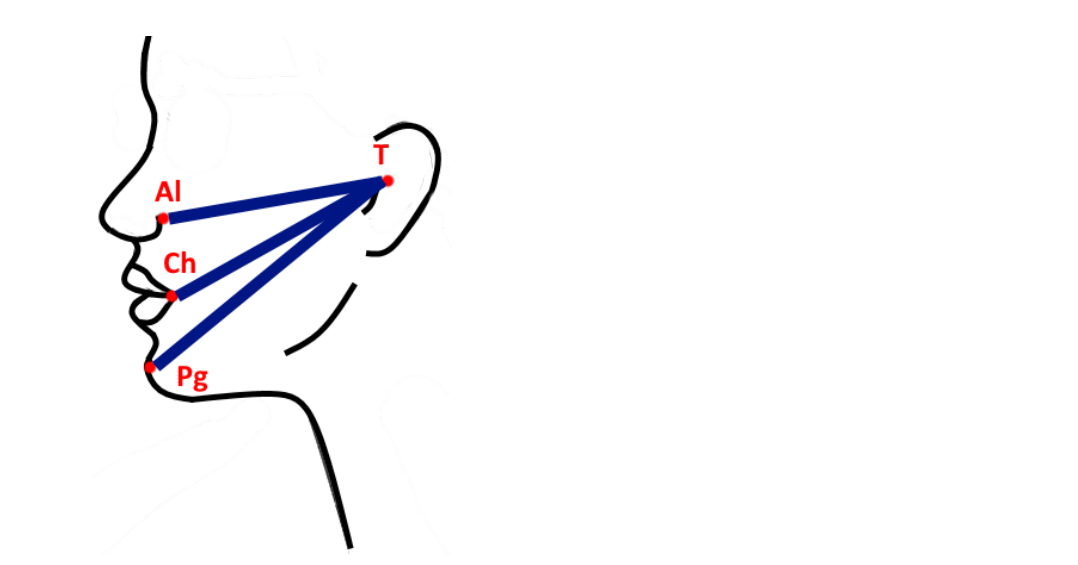
Figure 2. The location of the reference points within the skin and a schematic representation of the distance measurements between them.